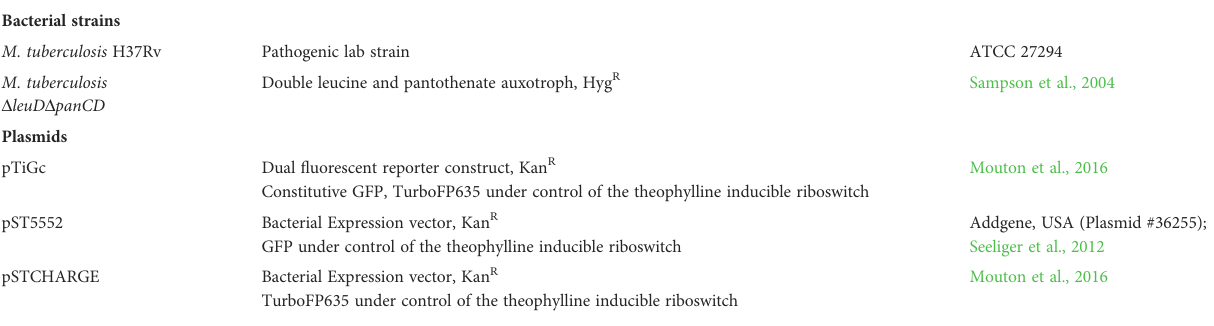
TABLE 1 Strains and plasmids utilized in this